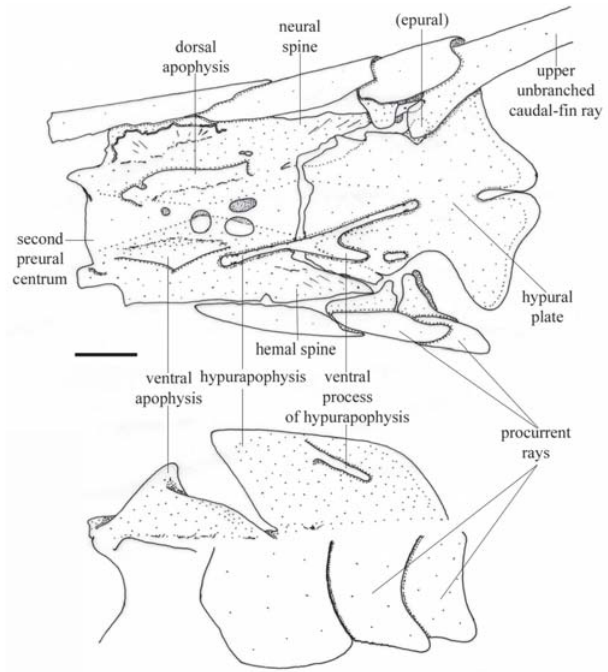
Fig. 50. Lateral view of the second preural centrum and caudal-fin skeleton (left side) of Lamontichthys avacanoeiro (MZUSP 61974, 113.7 mm SL, paratype). In detail (lower figure), the ventral view of hypurapophysis and lower apophysis. Cartilages not represented. Scale bar = 1